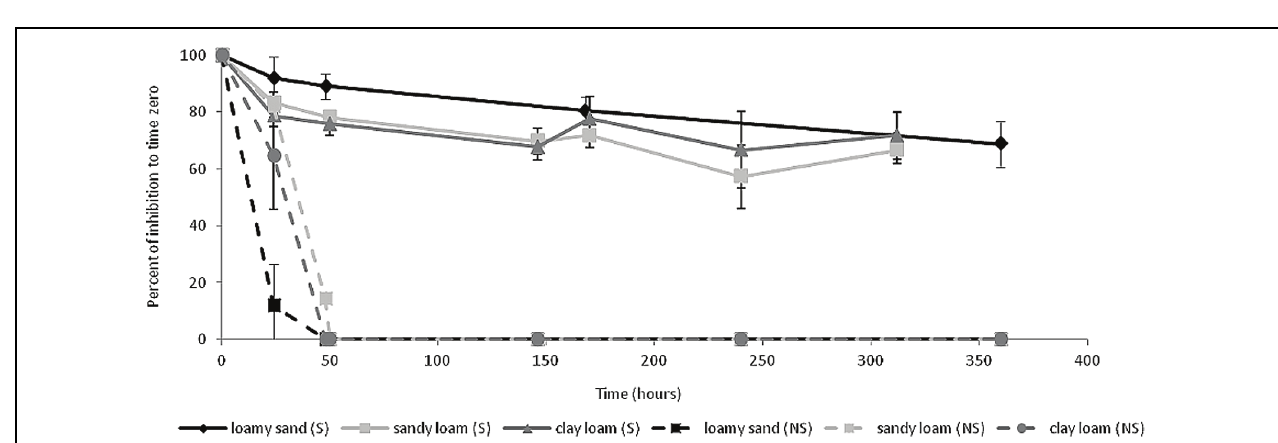
FIGURE 3 | Non-metric multidimensional scaling (NMDS) ordination of bacterial communities in the sandy loam (A), and clay (B) soil microcosms. Closer points indicate more similar communities. Antibiotic treatments are circled with dotted lines for 7 days microcosms and with dashed lines for 14 days microcosms; Ordination axes have no biological meaning. Circles in the NMDS plots were added to facilitate the visualization of the different treatments and does not represent significant differences between controls and antibiotic treatments. Non-amended control microcosms (C), antibiotic-amended microcosms (A); experimental initiation (T0- black circles), 7 days after experimental initiation (T7- dark gray circles), 14 days after experimental initiation (T14- light gray circles). Numbers at the end of sample’s name indicate the replicate number.